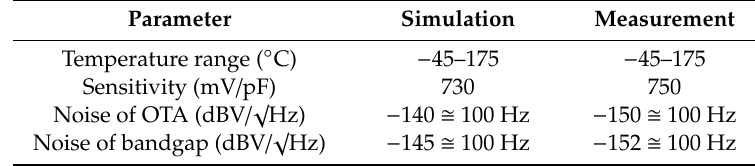
Table 2. Results between simulation data and measured